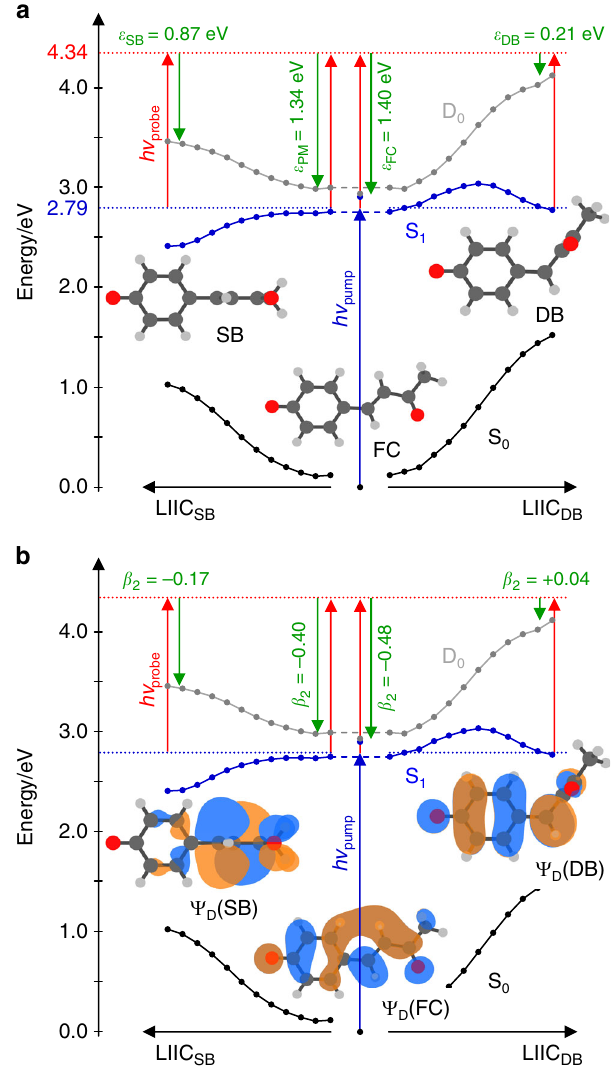
Fig. 2 Calculated potential energy surfaces for isomerisation coordinates. Calculated surface (XMCQDPT2) obtained from a linear interpolation in internal coordinates (LIIC) connecting: (left) the S 1 planar minimum (PM) and the S 1 minimum along the single-bond (SB) pathway; and (right) the S 1 PM and the S 1 minimum along the double-bond (DB) pathway. a Energetic analysis of excitation to the S 1 state. Structures indicate critical points on the S 1 potential energy surface, de fi ned as the Franck-Condon structure (FC) and the S 1 (SB) and S 1 (DB) minima. Pump and probe photon energies are included and expected maximum kinetic energies for the resultant photoelectrons detached from the FC ( ε FC ), PM ( ε PM ), SB ( ε SB ) and DB ( ε DB ). b Analysis of the modelled photoelectron angular distributions corresponding to the same regions on the S 1 potential energy surface. The Dyson orbitals, Ψ D , for SB and DB shown, Ψ D (SB) and Ψ D (DB), respectively. The Dyson orbitals for FC and PM are very similar and only Ψ D (FC) is included. In the structures, carbon atoms are dark grey, hydrogen atoms are light grey, and oxygen atoms are